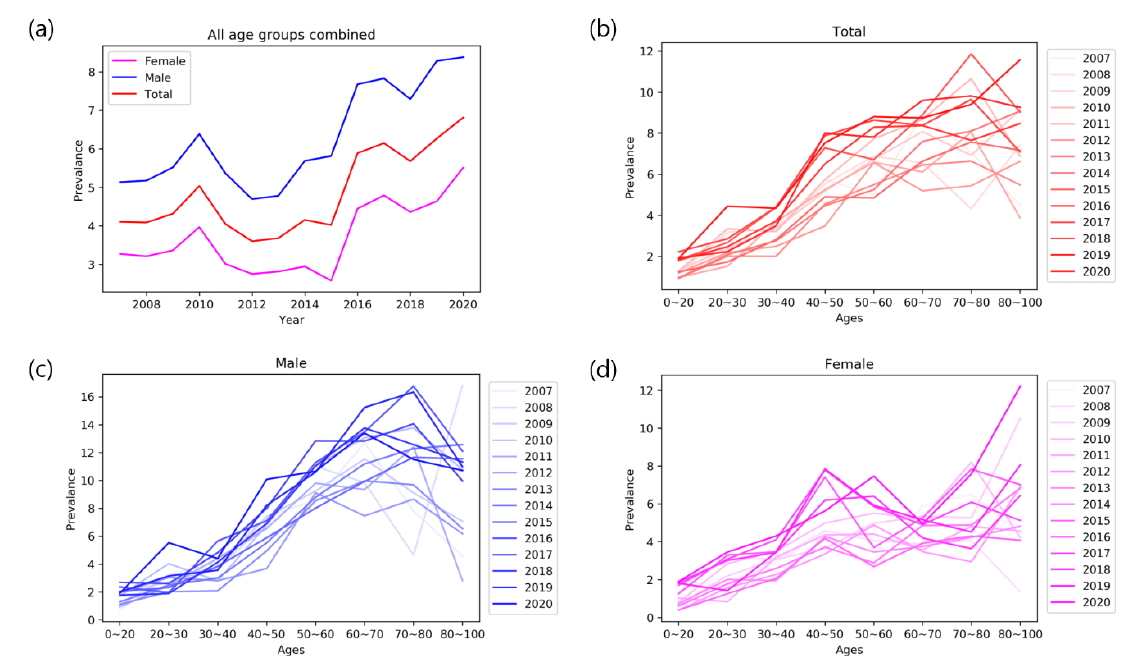
Figure 1. ( a ) The annual prevalence of PN per 1000 dermatology outpatient population (2007–2020) (total, male, female), ( b ) prevalence of PN (total) by age, ( c ) prevalence of PN (male) by age, and ( d ) prevalence of PN (female) by age.